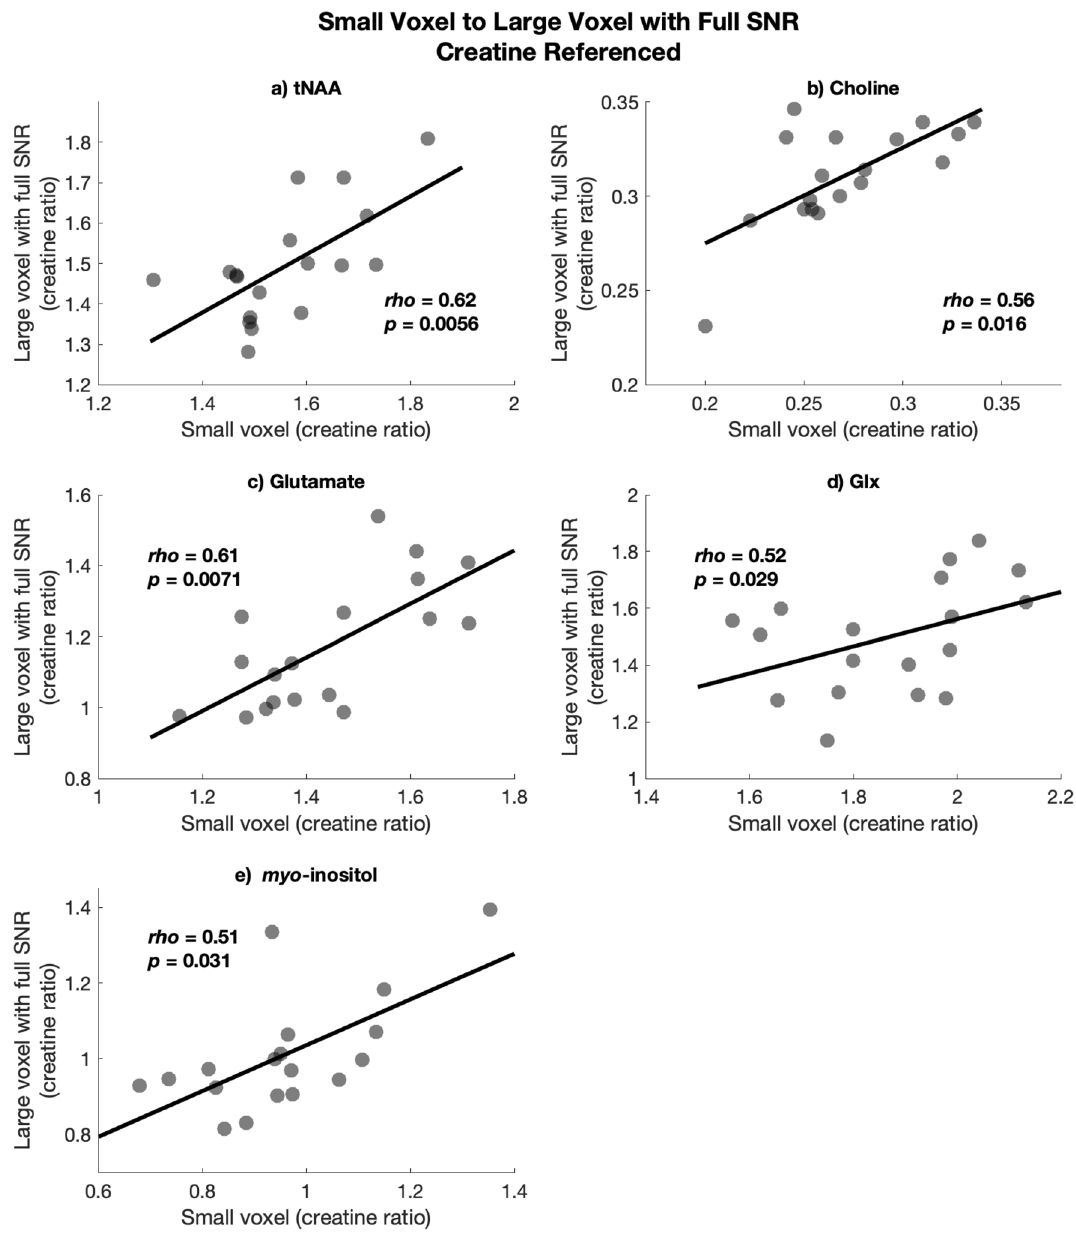
Figure 6. Spearman’s rho correlations between creatine-referenced values in the large voxel with full SNR on the y-axis and the small voxel on the x-axis for ( a ) tNAA, ( b ) Choline, ( c ) Glutamate, ( d ) Glx, and ( e ) myo-